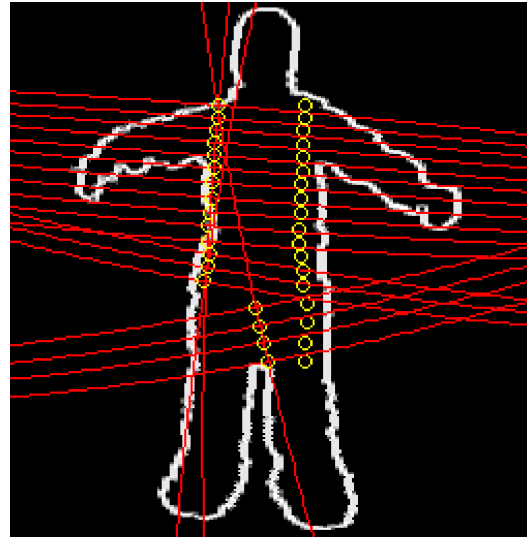
Figure 4. Geodesic distances in the spherical image. An example of sampled points from a part of the 3D model projected in the image. The dots represented by yellow circles correspond to the sampled points of a part of the 3D model projected in the image.